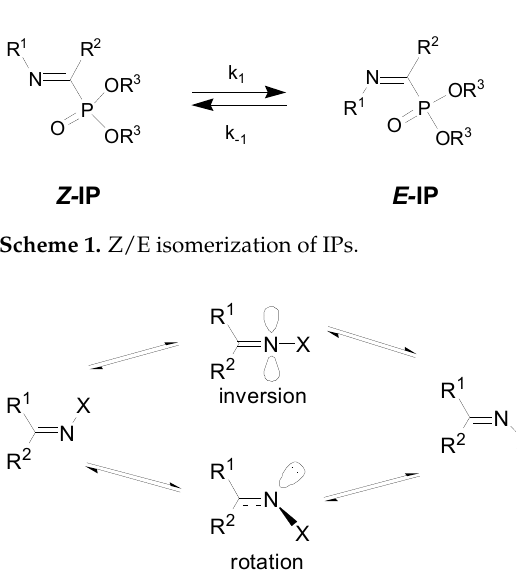
isomers of IPs ( δ P − 0.1–3.3 ppm, δ F − 66.2–70.2 ppm) are high-field shifted compared to the corresponding E-isomers ( δ P 1.5–4.9 ppm, δ F − 61–62 ppm) [9,11–13]. Structural